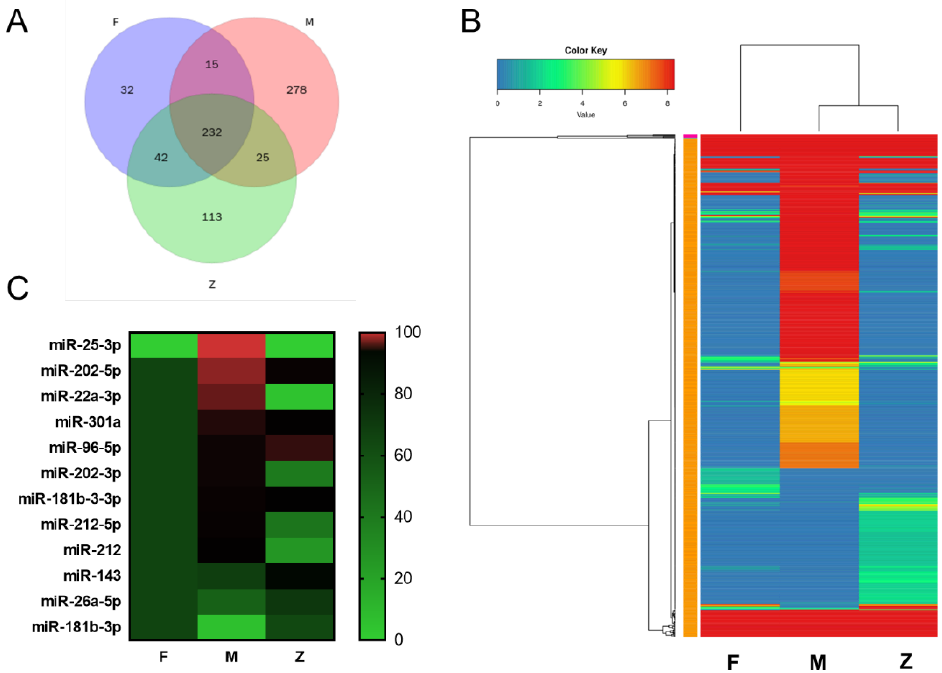
Figure 5. Cluster analysis of differential miRNAs of males, females, and pseudo-females: ( A ) Wayne analysis on unique miRNAs identified in three groups. ( B ) The cluster map of differential miRNAs expression. F: female, M: male, Z: pseudo-female. ( C ) The cluster map of differential miRNAs expression related to gonadal development. F: female, M: male, Z: pseudo-female.